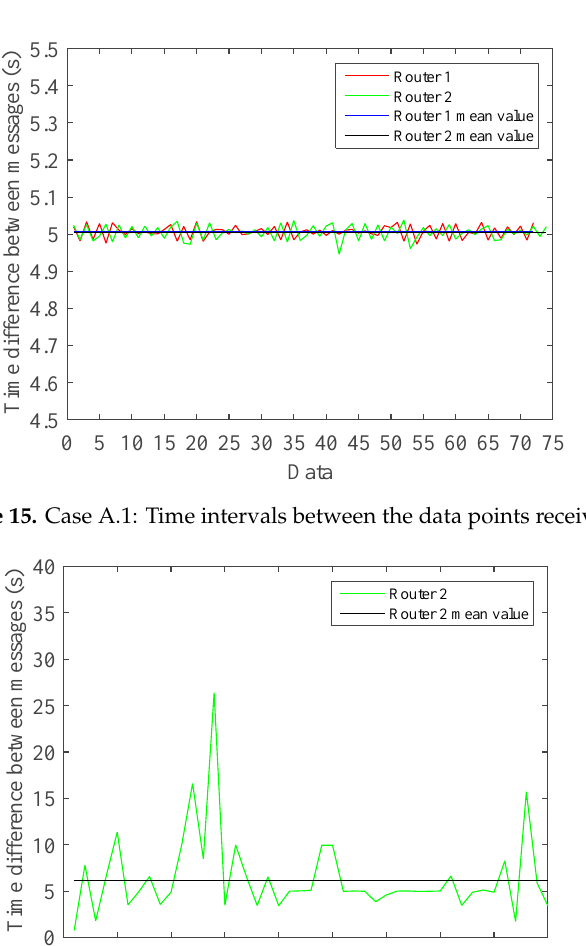
Figure 15. Case A.1: Time intervals between the data points received.